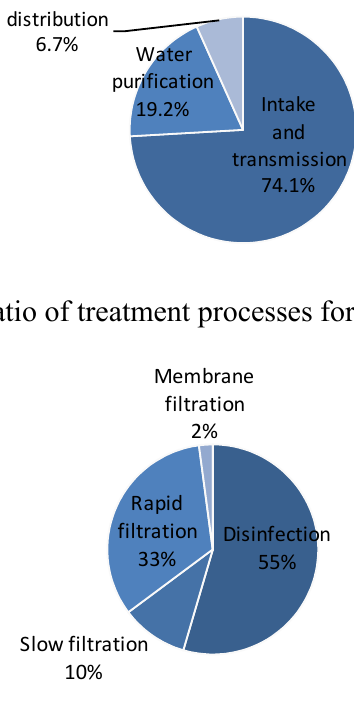
Figure 6. Relationship between energy consumption rates and treated water volumes of waterworks facilities in